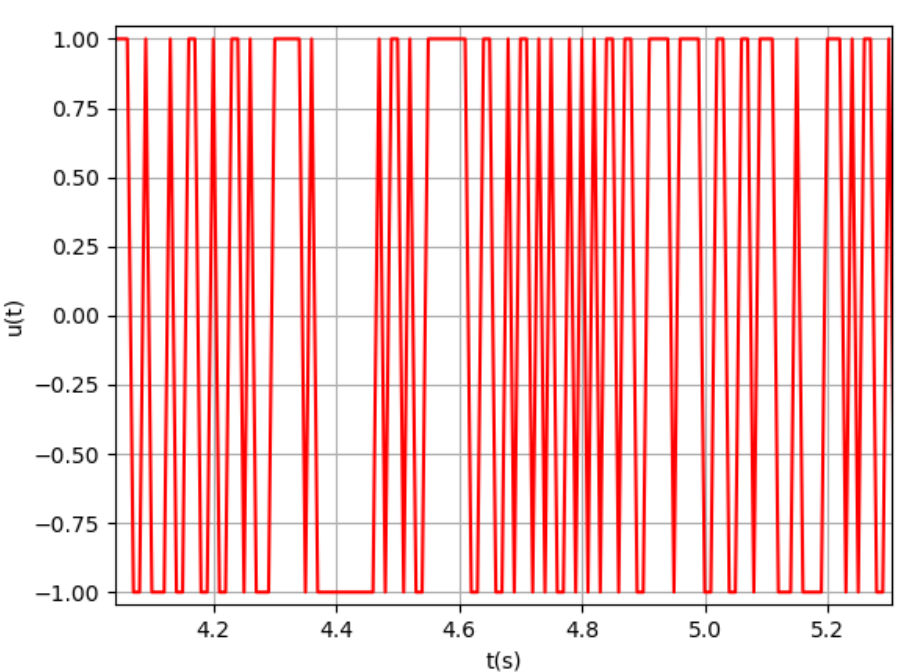
Figure 8. Resultant control signal: sensor noisy case, a zoom-in version of the previous picture.